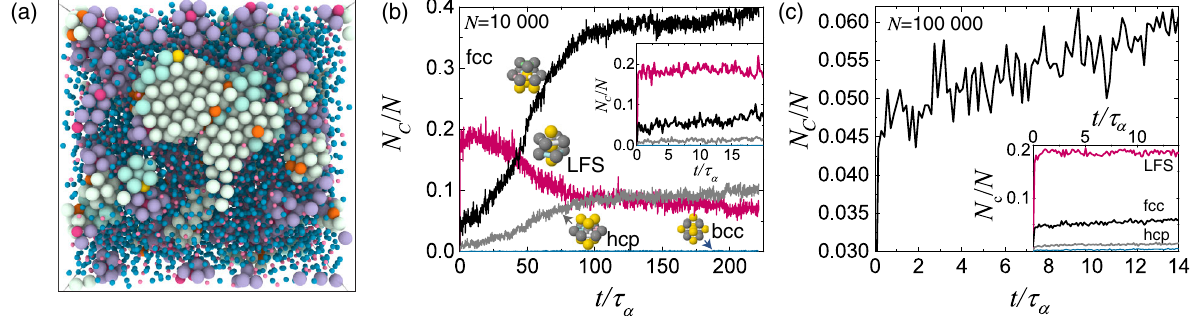
FIG. 1. Structural analysis of crystallization in the Kob-Andersen glass former. (a) Particle snapshot at time t ≈ 36 τ α at T ¼ 0 . 40 and N ¼ 10 000 . We observe a fcc-dominated crystallite of A particles. Light green and yellow particles are fcc for A and B particles, respectively, light blue and orange are hcp, purple and dark pink are bicapped antiprism liquid locally favored structure (LFS), and dark blue and light pink particles are liquid. (b) Population of local structures as a function of time reveals rapid crystallization of fcc and hcp for N ¼ 10 000 . bcc is found in very small quantities, and the bicapped square antiprism liquid LFS (which is incompatible with fcc and hcp) is also shown. The inset shows that at short times ( ≲ 5 τ α ), we cannot infer any crystal growth within the fluctuations. (c) Even more rapid crystallization occurs when N ¼ 100 000 ; here irreversible growth in the fcc population is found within one relaxation time. Inset: Liquid LFS and hcp populations are compared with fcc population, as shown in the main